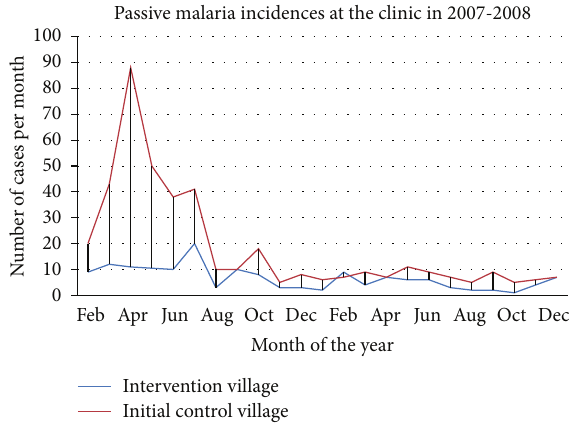
Figure 2: Monthly malaria cases in Kanyaboli area before and after intervention. ∗ Month of Netprotect hunging in control